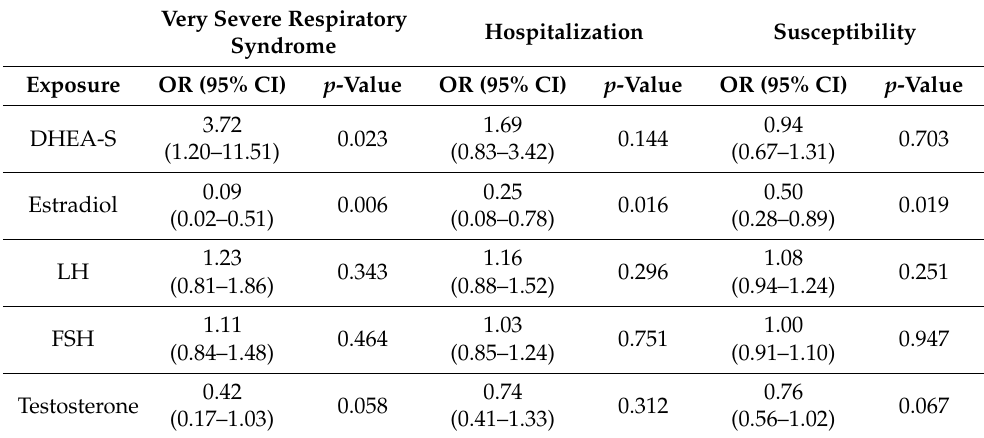
Table 1. MVMR analysis of CNS-regulated hormone SNPs and COVID-19 severity and susceptibility.